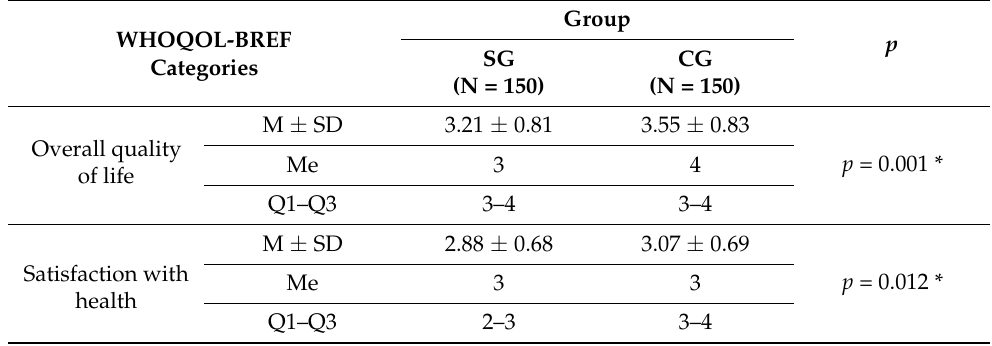
Table 7. The results of the assessment of the areas of quality of life in SG and